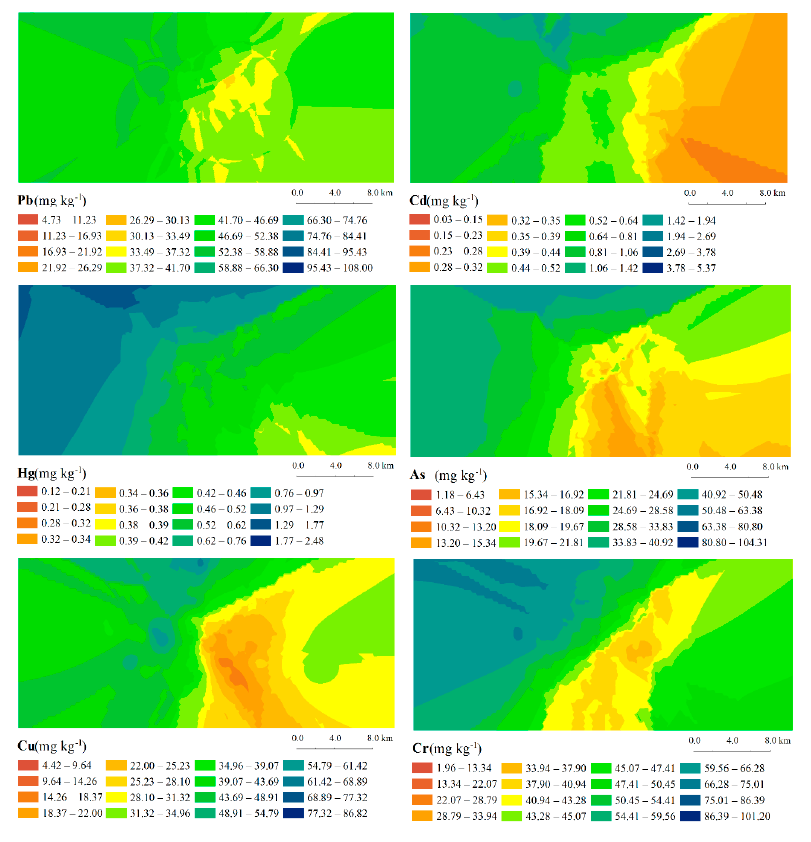
Figure 2. Spatial distributions of heavy metal concentrations in soils from the study area obtained with empirical Bayesian kriging interpolation.